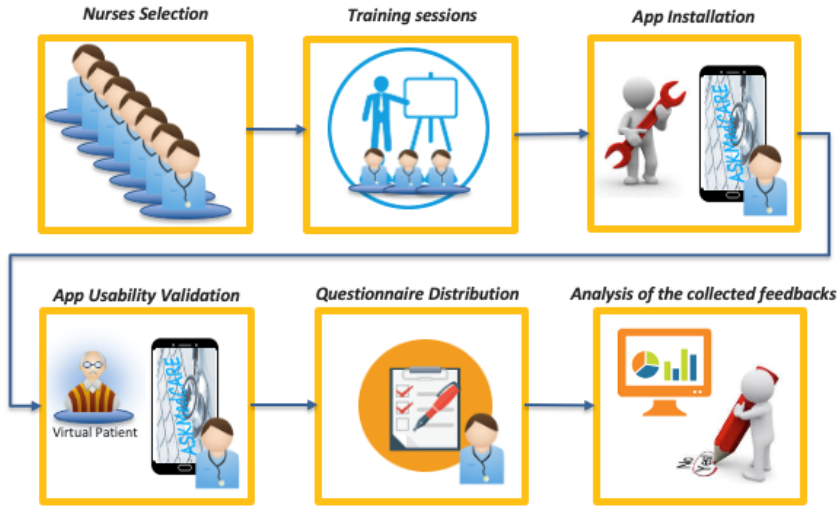
Figure 6. Preliminary Experimental Activity: Stages